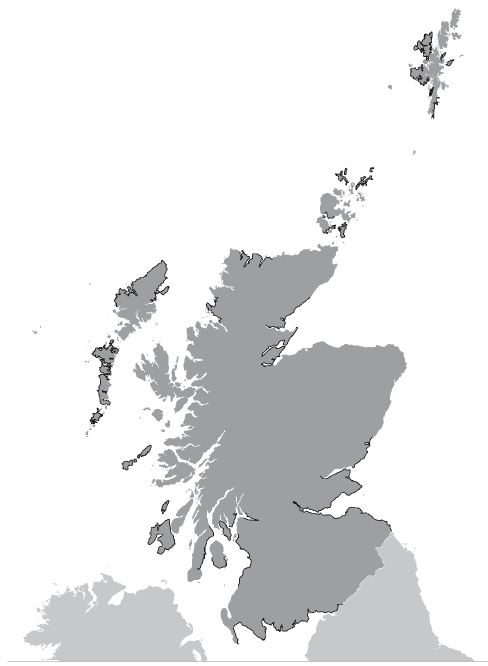
Figure 1. Map of Scotland showing the 35% of the coast which has been covered by CZA Surveys.